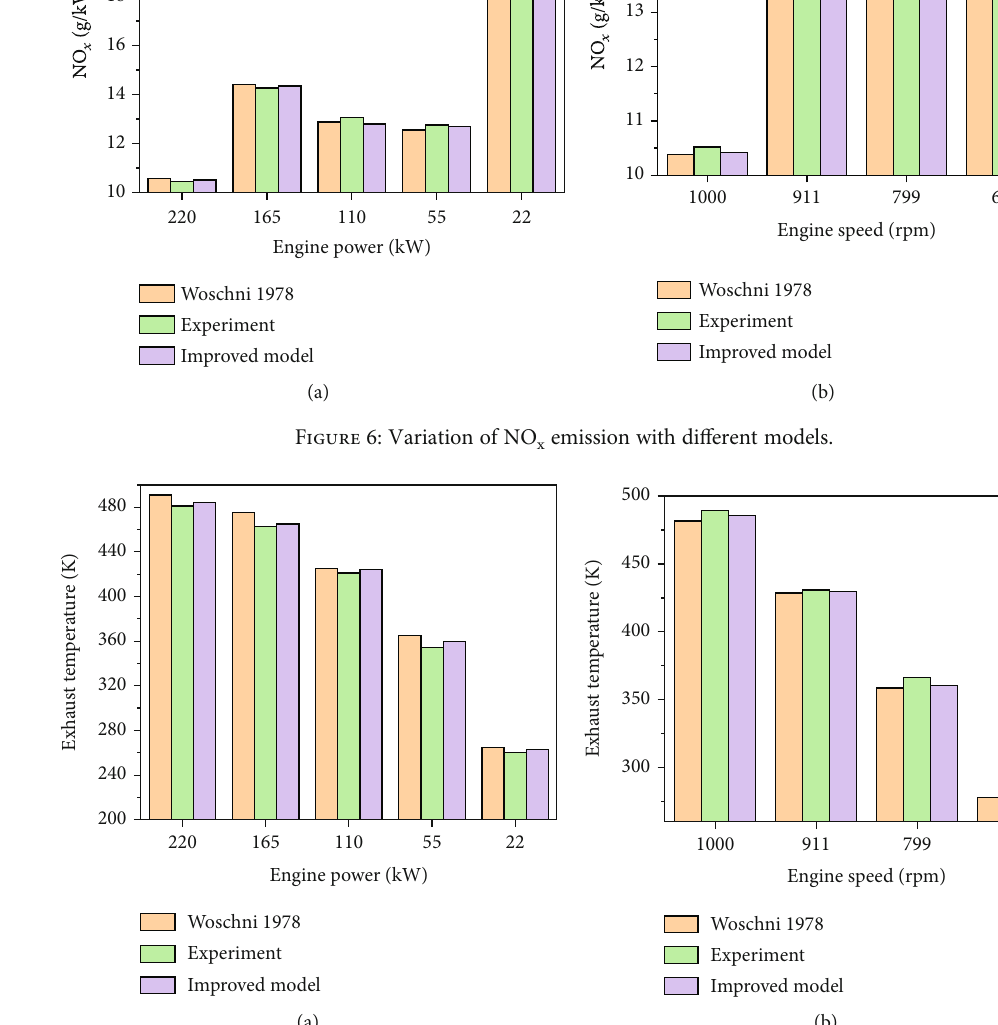
Figure 7: Variation of exhaust temperature with di ff erent